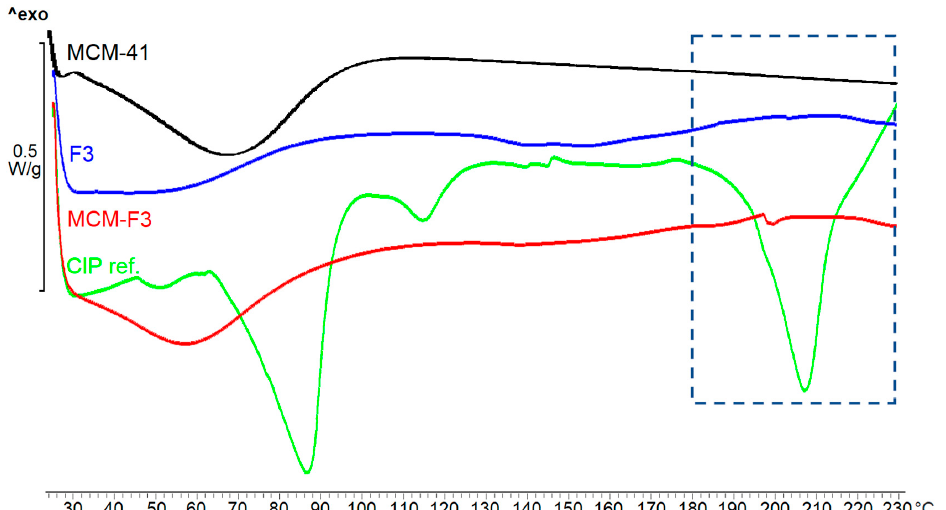
Figure 5. The DSC thermograms of solid films of MCM-F3, F3, unloaded MCM-41 and CIP reference.